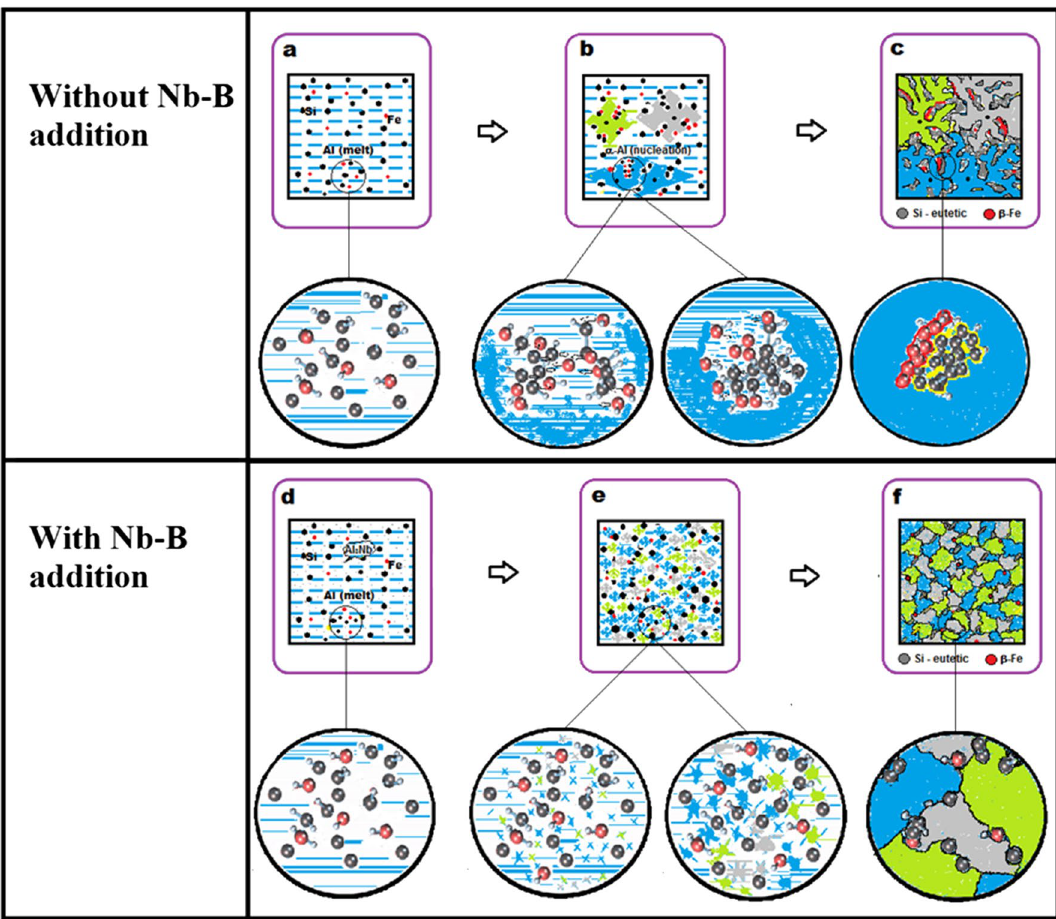
Figure 14. Illustration of the dispersion mechanism of β-Fe particles in the eutectic front of solidification of the material, without the addition of Nb + B ( a, b, and c ), with the addition of Nb + B ( d, e, and f ). Liquid metal ( a , and d ). Beginning of the solidification process and growth of the grain ( b , and e ). End of solidification ( c , and f ) (Microsoft Paint.Ink